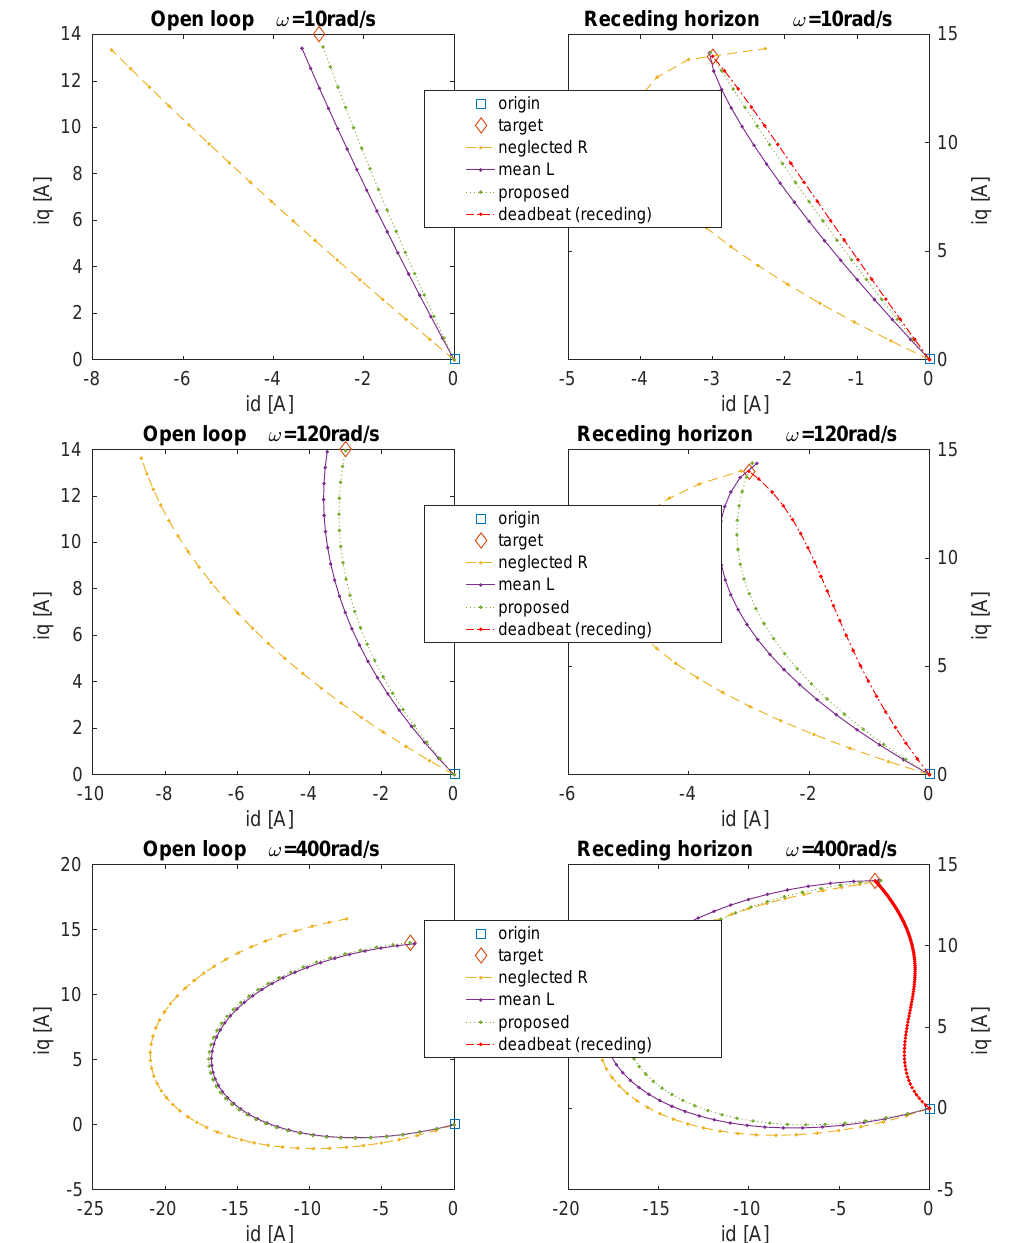
Figure 2. Comparison of studied versions of time-optimal control and deadbeat control on stator current reference step change from zero to [ − 3,14 ] A for ω = 10 rad/s ( top row), ω = 120 rad/s ( middle row), and ω = 400 rad/s ( bottom row). The difference of the solutions in the origin is visible in the open-loop strategy ( left ), its impact on the receding horizon reevaluation in each sampling period ( right ), sampling times are denoted by dots on the full